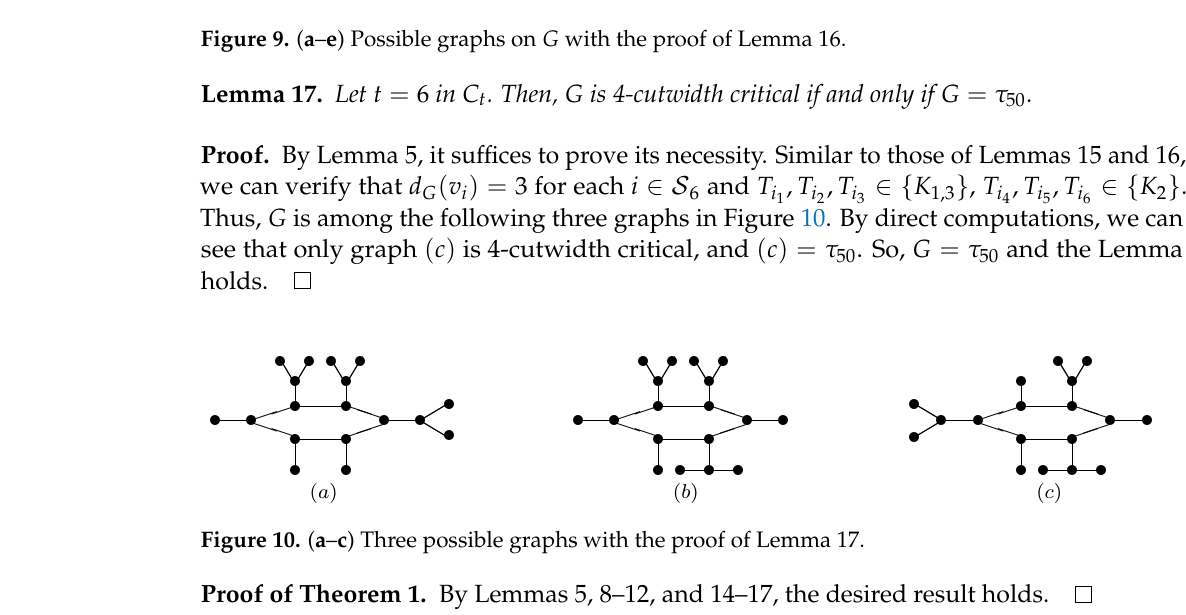
Fig.10. Three possible graphs with the proof of Lemma 3.14